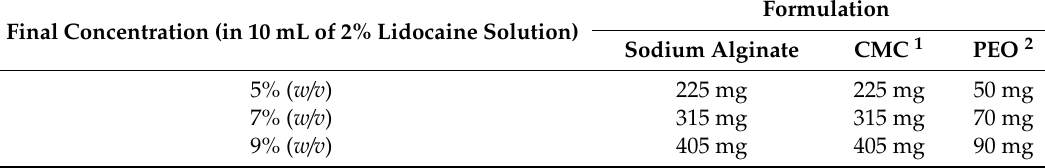
Table 1. Formulation ratios used in this study.